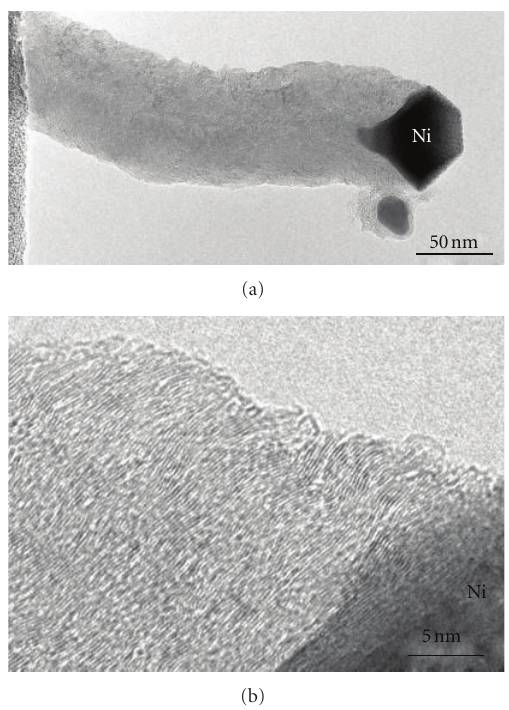
Figure 6: (a) Cup-stacked-type carbon nanotube synthesized by heating Ni-doped C 60 nanowhiskers (specimen B) at 1323 K. (b) High-resolution image of the cup-stacked-type carbon nanotube depicted in